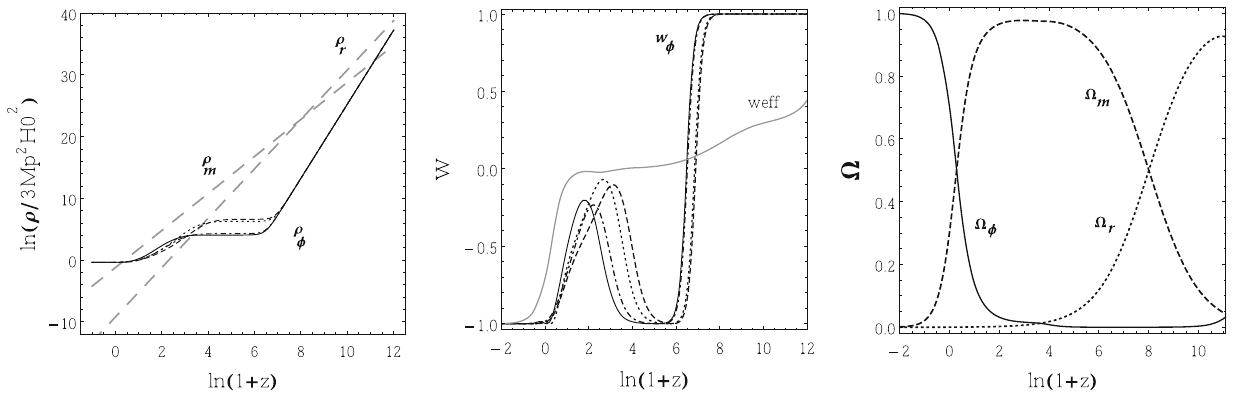
n = 3, α = 6 (dashed). The right panel exhibits the evolution of energy density parameter (cid:7) versus z for n = 3 and α = 6. The solid, dashed = 2, and dotted lines represent (cid:7) φ , (cid:7) m and (cid:7) r ,